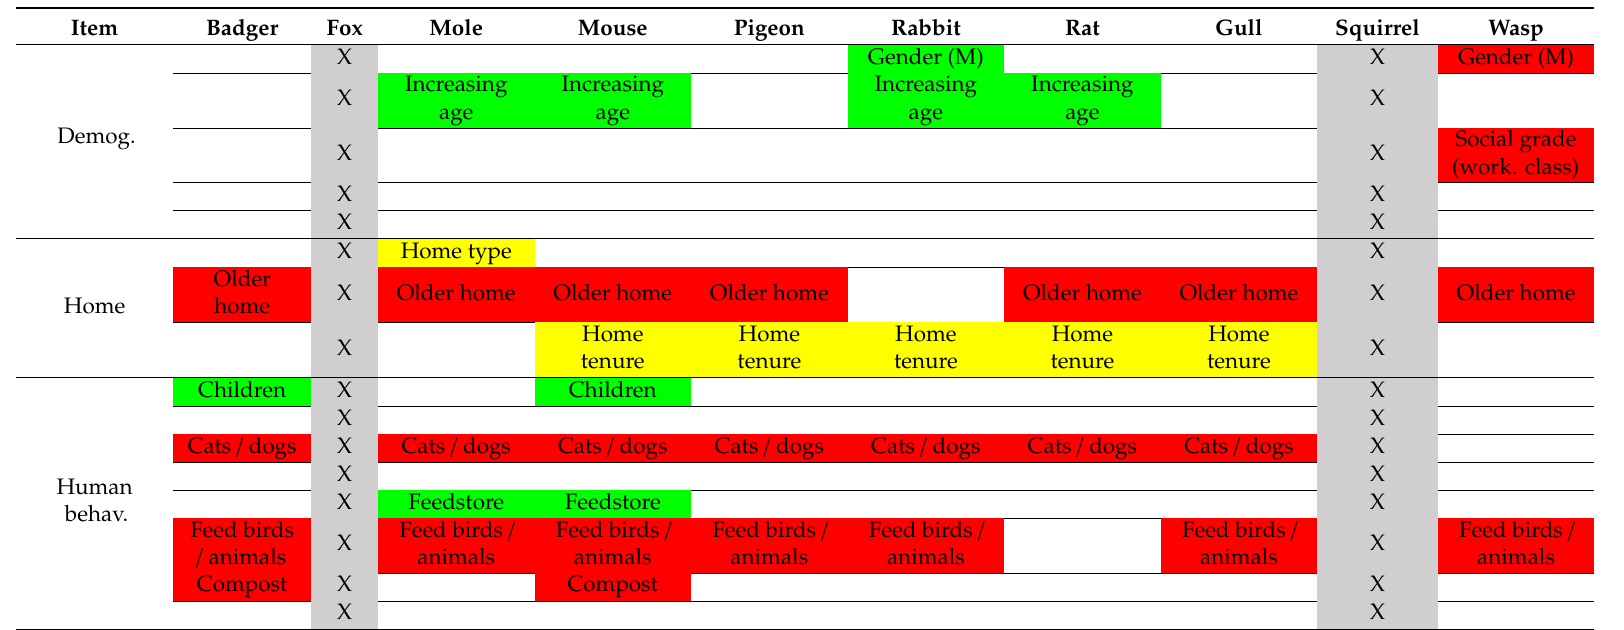
Table 4. Factors associated with people’s negative attitudes towards eight species ( n = 1828). Factors are grouped under: Demog. = ‘Demography’, Home = ‘Home’, Human behav. = ‘Human behaviour’, Perc. spp. traits = ‘Perceived species traits’, and Perc. about spp. = ‘Perceptions about species’. Factors shown in red were associated with a more positive attitude, those shown in green were associated with a more negative attitude, and those shown yellow were associated with a more complex e ff ect. See list of abbreviations for factors in Supplementary Materials Table